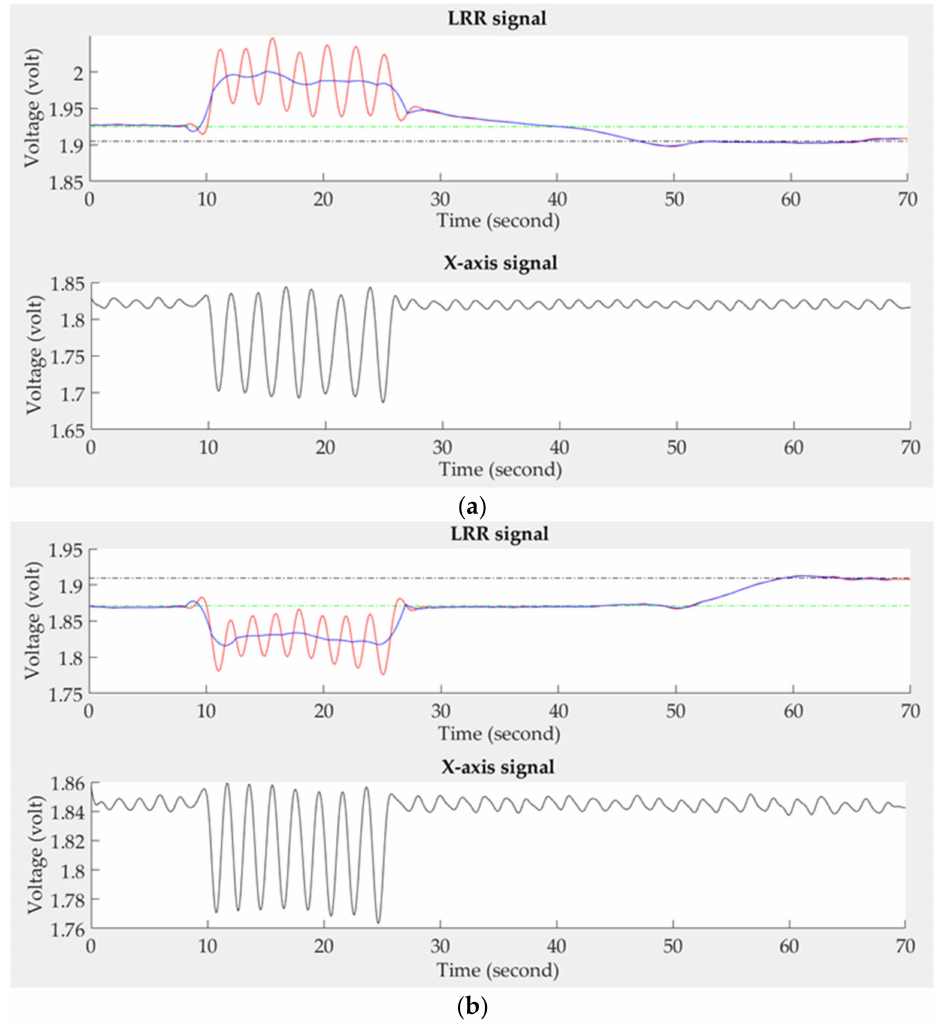
Figure 6. ( a ) The phase angle between the LRR signal and the x -axis signal is 180 ◦ because the PPG sensor detects the upstream of venous blood flow, ( b ) The LRR signal has the drift phenomenon.